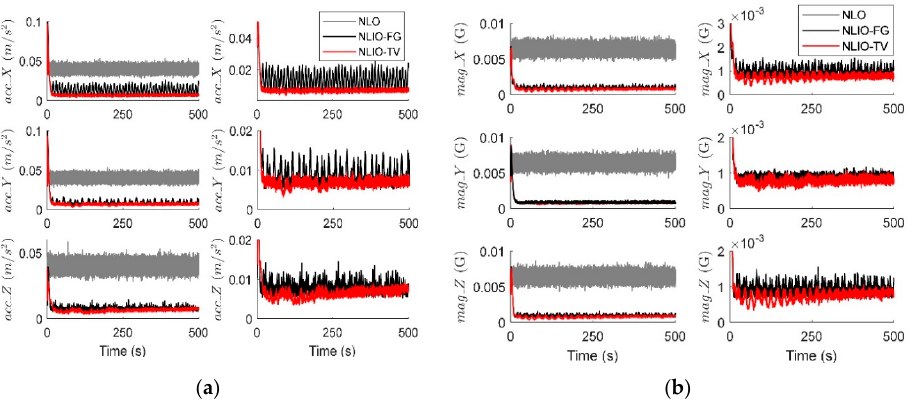
Figure 3. Averaged absolute vector measurement estimation errors over 100 simulations for Case 1. ( a ) Accelerometer measurement estimation errors evaluated by the auxiliary observers of the nonlinear observer (NLO) and nonlinear interconnected observer (NLIO). ( b ) Magnetometer measurement estimation errors evaluated by the auxiliary observers of the NLO and NLIOs. Since the NLO does not estimate the vector measurements, its vector measurement errors are identical to the difference between the sensor measurements and the truth values. The measurement errors’ formula is expressed as | v m − v truth | . For the NLIO, the vector measurement estimation error refers to the difference between the sensor measurement value and the truth value. Its formula is expressed as (cid:12) . To interpret the references to the color and line types in this figure, readers are invited to refer to the web version of this article.